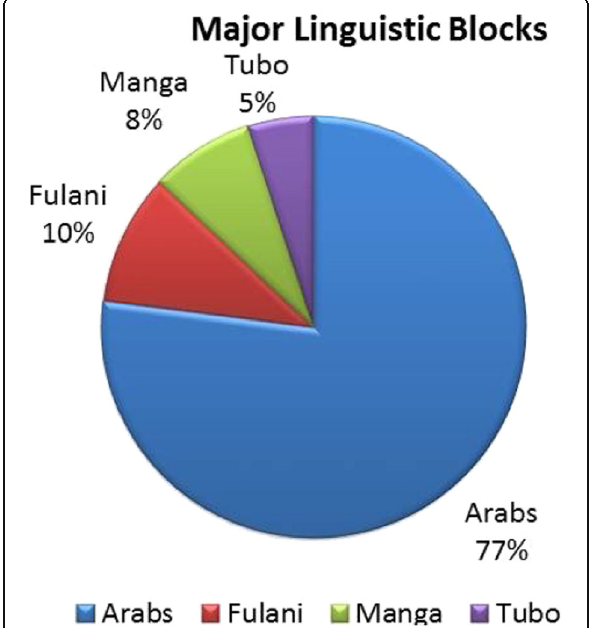
Figure 3 Major linguistic blocks (mother tongues) of camel-owning peoples in Northeastern Nigeria